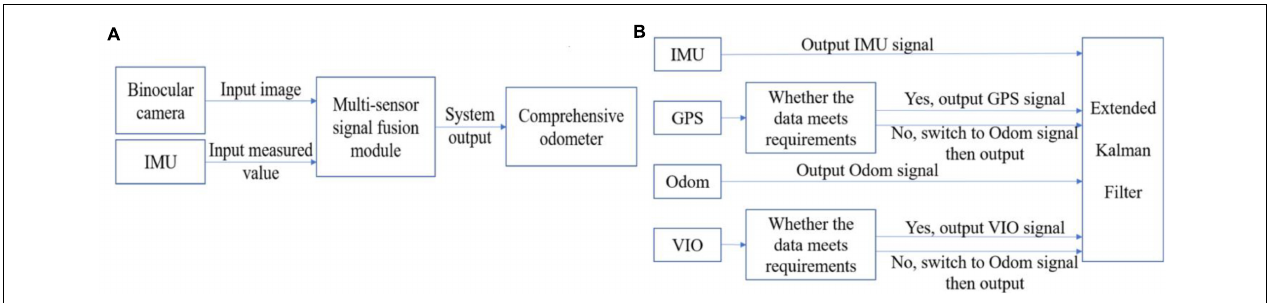
FIGURE 1 | (A) Overall algorithm framework and (B) multi-sensor signal fusion